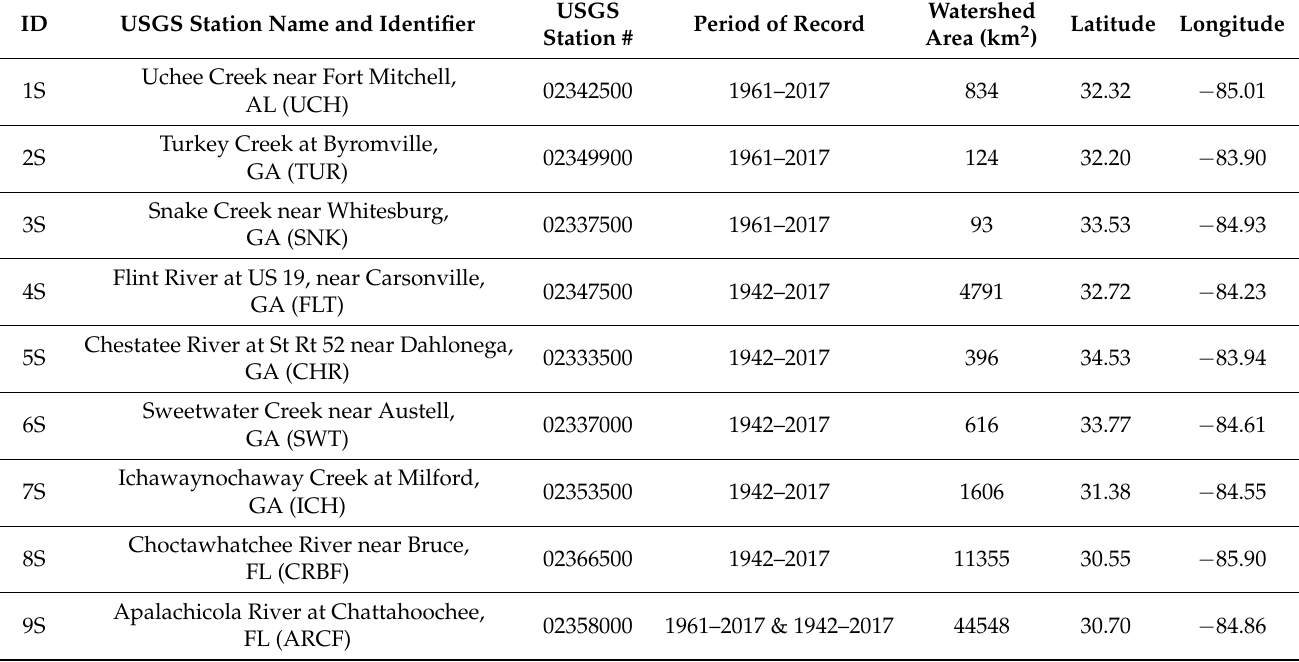
Table 1. Information of the 9 USGS stations: ID, station name and identifier, USGS station number (#), period of record, watershed area, latitude, and